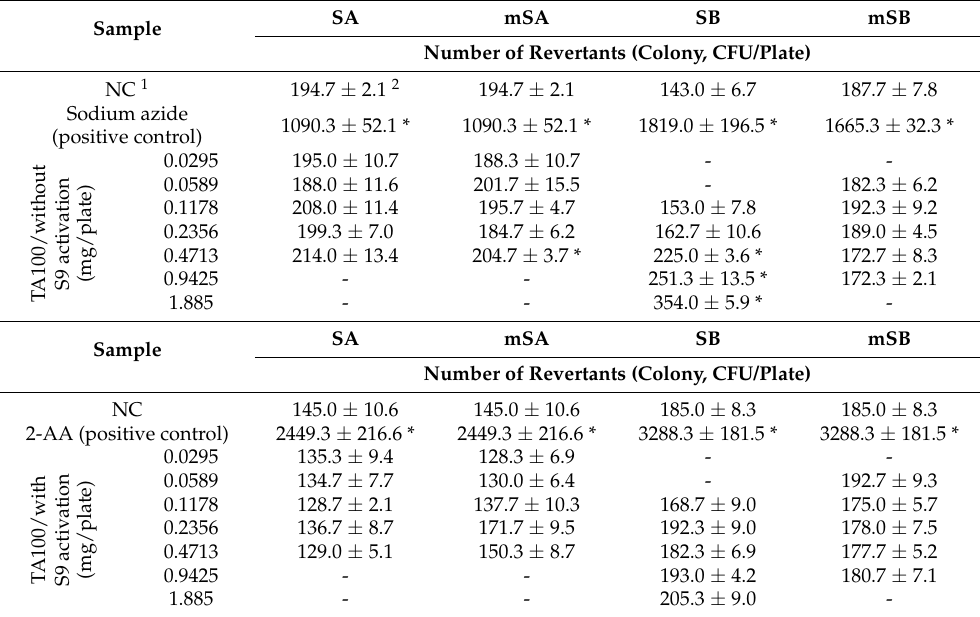
Table 5. Revertant changes of SA, mSA, SB, and mSB in Salmonella TA100 mutagenicity test with or without